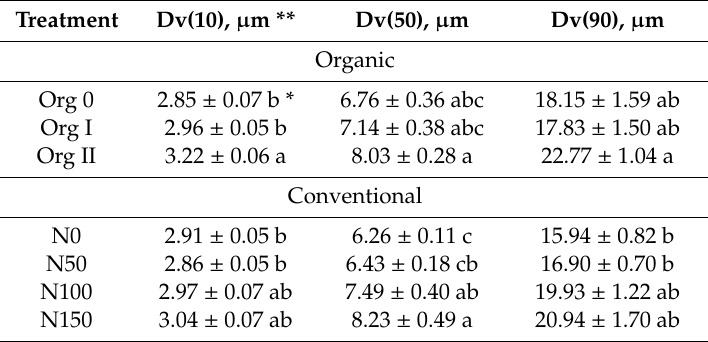
Table 5. Mean values ( ± SE) of starch granule size distribution over experimental years in the comparison of farming system